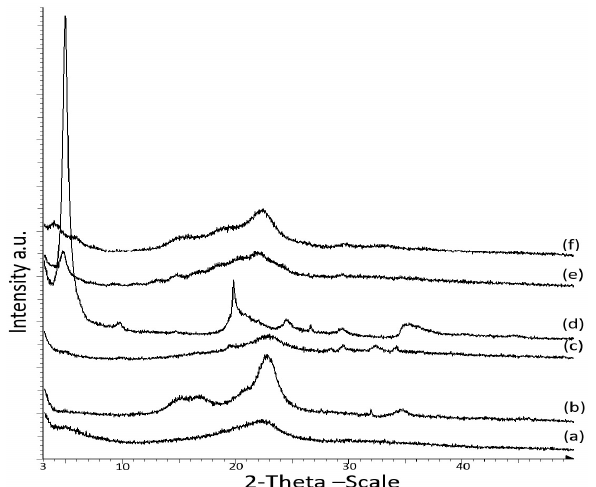
Figure 3. X-ray diffraction (XRD) patterns of ( a ) matrix κ-carrageenan; ( b ) CNC powder; ( c ) κ- carr/CNC bionanocomposite film; ( d ) OMMT powder; ( e ) κ-carr/OMMT bionanocomposite film,